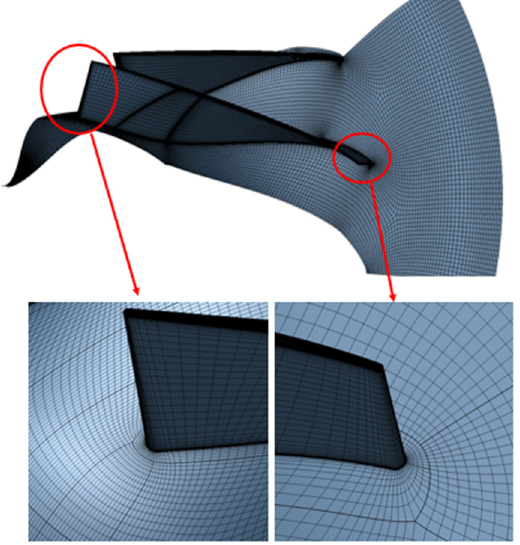
Figure 4. Mesh details around the leading edge and trailing edge.